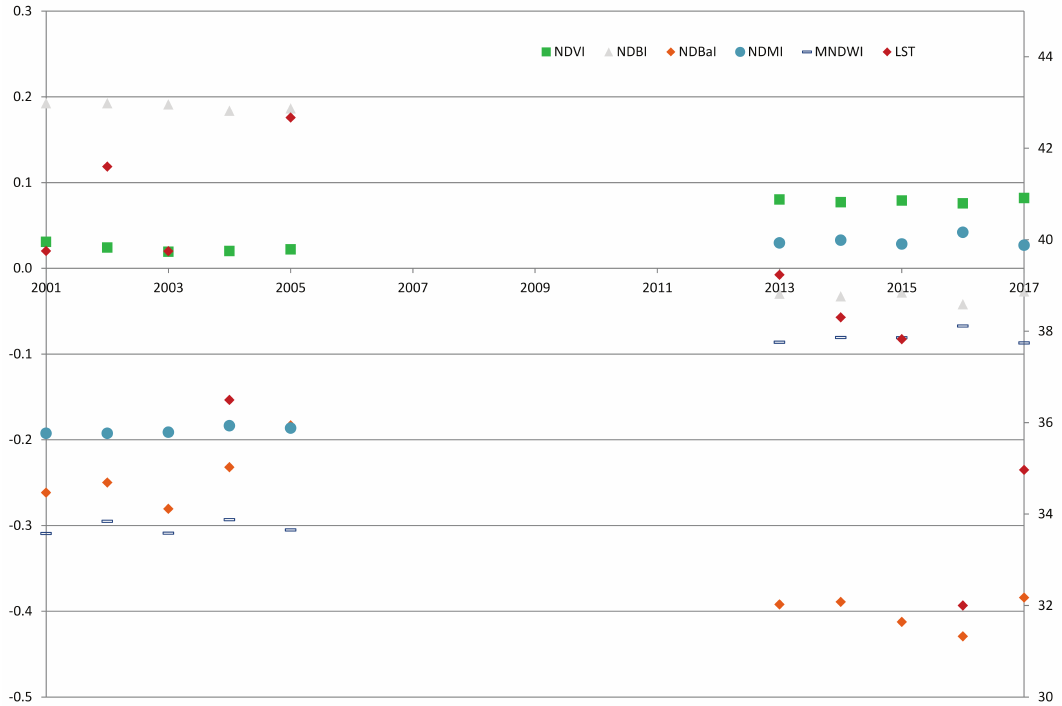
Figure 9. Median LST (right) and spectral indices (left) for the Confluence